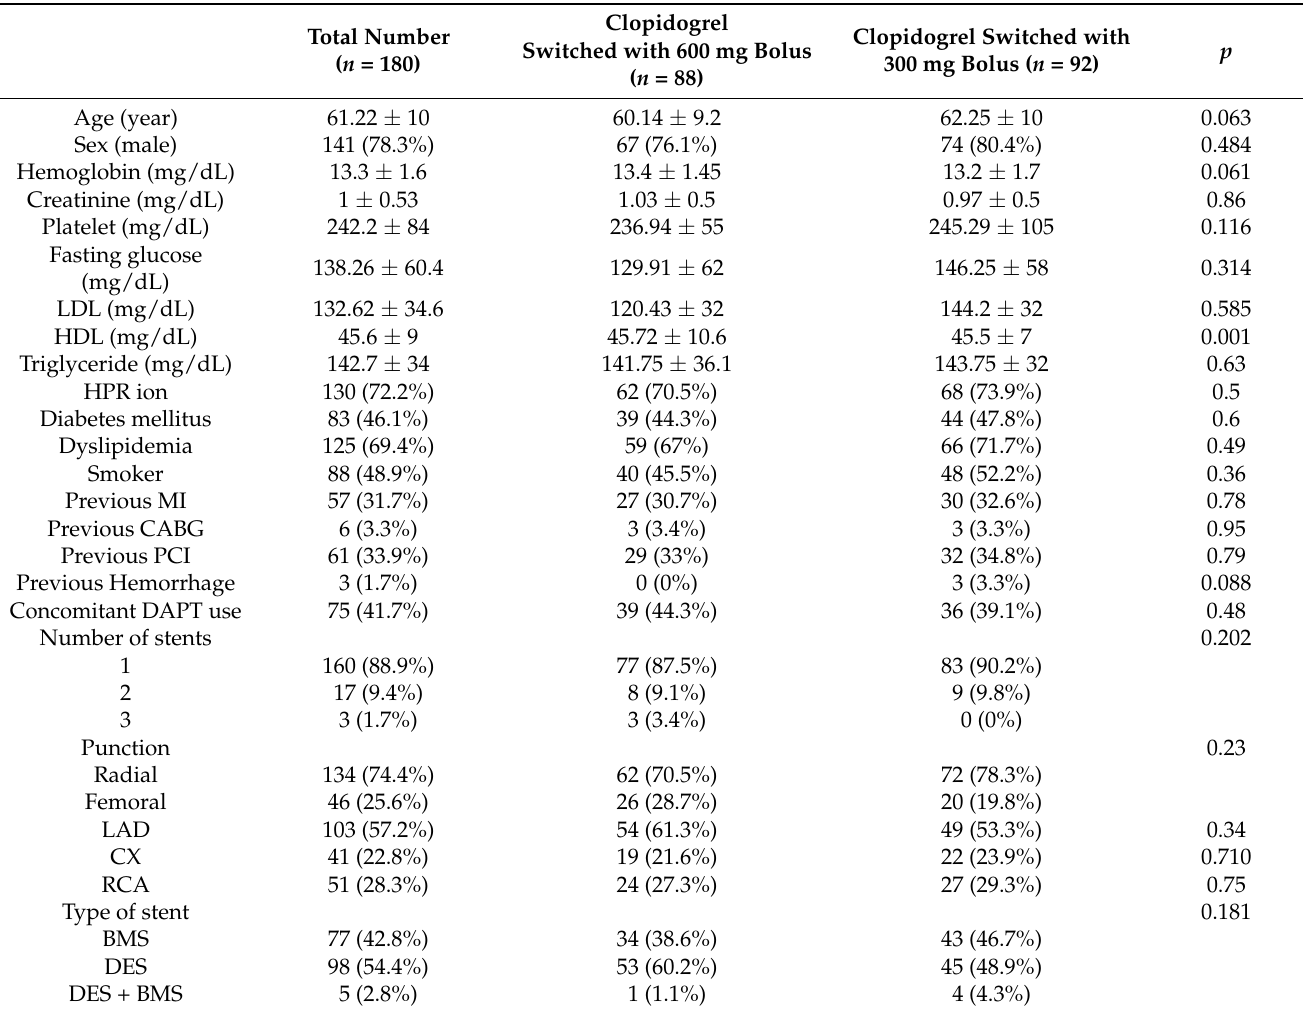
Table 1. Baseline characteristics of the study population.